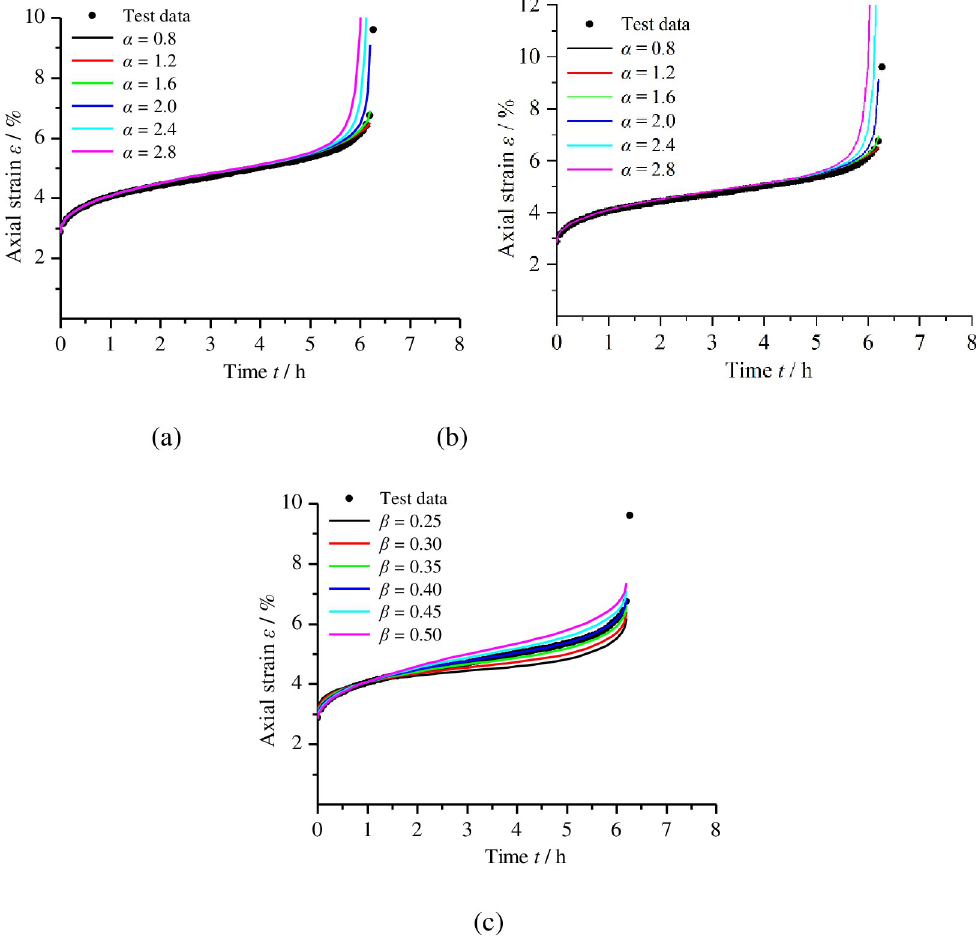
Fig 13. Sensitivity of the creep strain to the parameters. (a) The effect of α ; (b) the effect of γ ; (c) the effect of β .